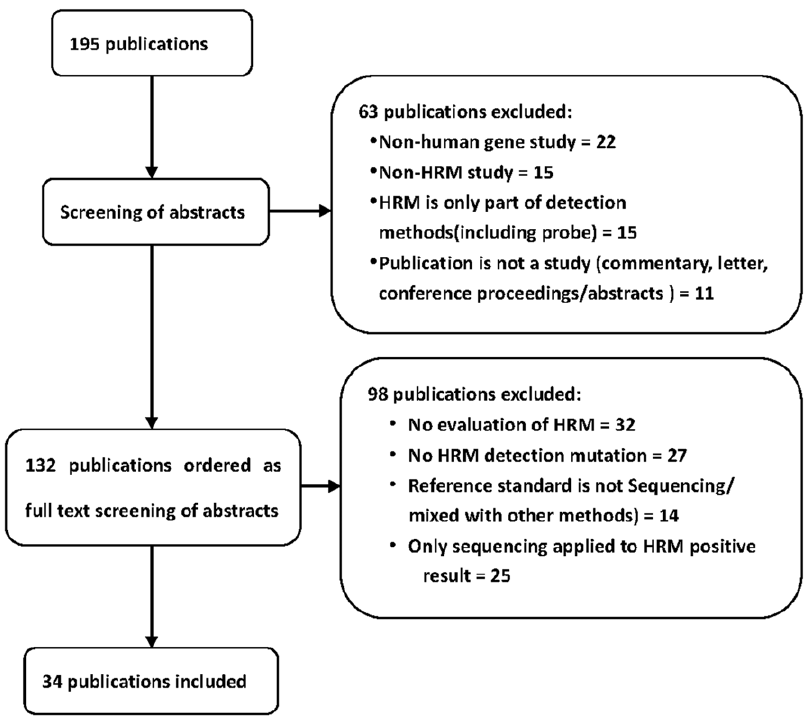
Figure 1. Flowchart for the selection of articles for meta-analysis.